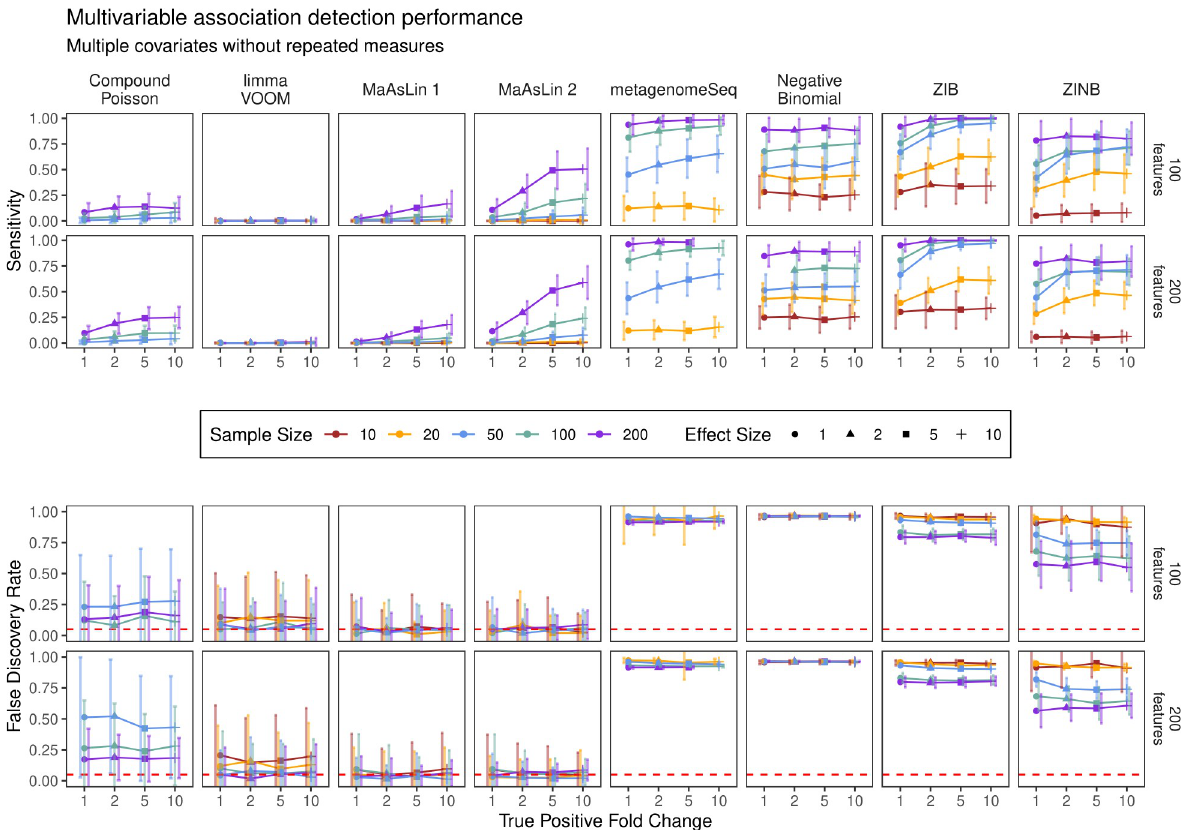
Fig 3. MaAsLin 2 facilitates multivariable association discovery in large-scale human epidemiological and other microbial community studies. Synthetic datasets containing five “metadata” with varying types of induced feature associations were analyzed using a variety of multivariable approaches ( S1C Fig) . As measured by power (recall) and false discovery rate (FDR), MaAsLin 2’s default linear model outperformed other methods in controlling FDR while maintaining power across true-positive fold-change values, regardless of the total number of features. As expected, MaAsLin 2 has better power for stronger effect sizes, eventually attaining the highest power among all FDR-controlling methods (full results in S1– S8 Data ). Red line parallel to the x-axis is the nominal FDR. Values are averages over 100 iterations for each parameter combination. The x-axis (effect size) within each panel represents the linear effect size parameter; a higher effect size represents a stronger association. For visualization purposes, the best-performing methods from each class of models (as measured by average F1 score) are shown. Methods are sorted by increasing order of average F1 score across all simulation parameters in this